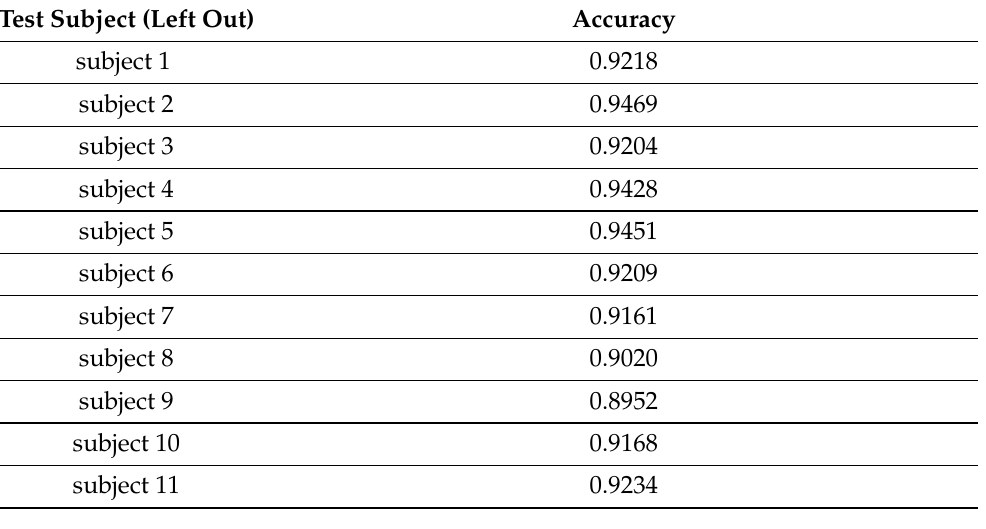
Table 1. Table showing the accuracy of each subject being left out during training.